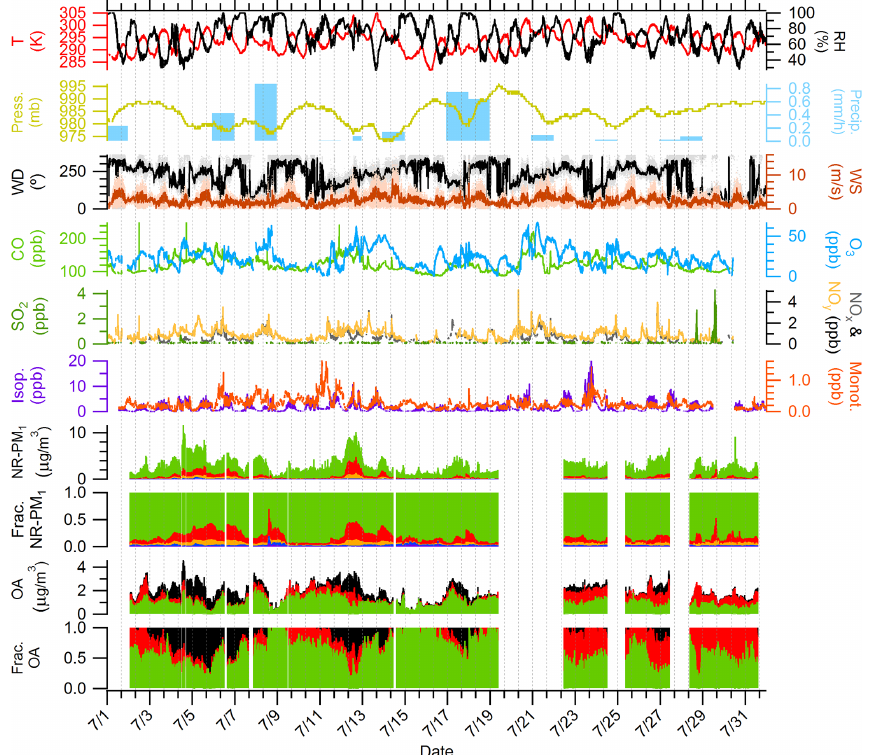
Figure 1. Overview of time series of the following from top to bottom: temperature ( T ) and RH; pressure (Press.) and precipitation (Precip.); wind direction (WD) and wind speed (WS); CO and O 3 ; SO 2 , NO x , and NO y ; isoprene (Isop.) and total monoterpenes (Monot.); particulate OA (green), NO 3 (blue), SO 4 (red), NH 4 (orange), and Chl (purple); fraction of species to total NR-PM 1 ; OA factors derived from PMF; and fractional contribution of OA factors to total OA. OA factors are colored as follows: MO-OOA (black), IEPOX-OA (red), and 91Fac (green). Precipitation data are provided from the NADP site in Cheboygan County, MI. Trace gas data (CO, O 3 , SO 2 , NO x , and NO y ) are measured from the 6m inlet on the MAQL. Meteorological data ( T , RH, Press., WD, and WS) and VOC data (Isop. and Monot.) are measured from the 34m inlet on the PROPHET tower. The OA time series include data from both heights (6 and 30m), with the sampling switched at 10min intervals. The date format is